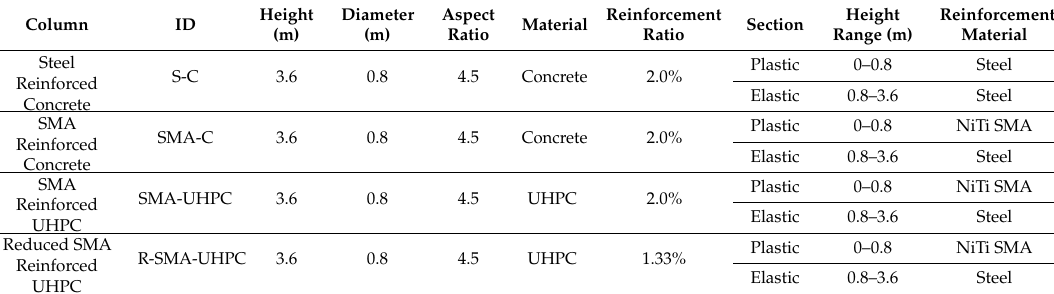
Figure 1. Column sections. Table 1. Geometry and material configurations of Table 1. Geometry and material configurations of columns.